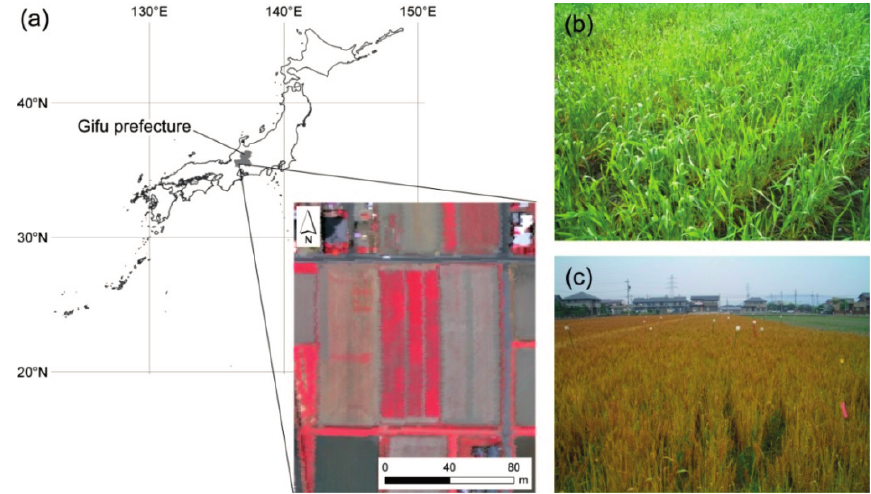
Figure 1. Location and photographs of the experimental site. ( a ) Location of the experimental site; ( b ) Photograph of the winter wheat on 25 April 2006 (just before heading); and ( c ) Photograph of the winter wheat on 2 June 2006 (10 days before